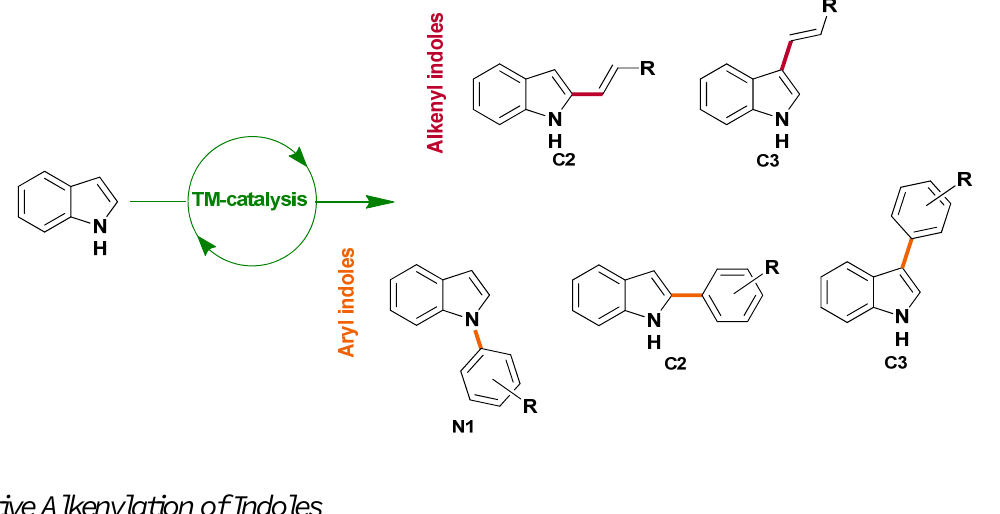
Table 1. Influence of the catalytic system on the C